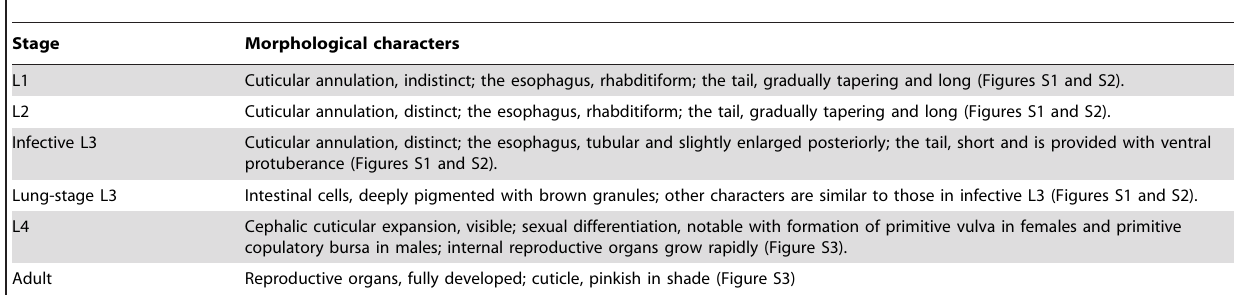
Table 1. Morphological characteristics of the worms in each developmental stage of N. brasiliensis